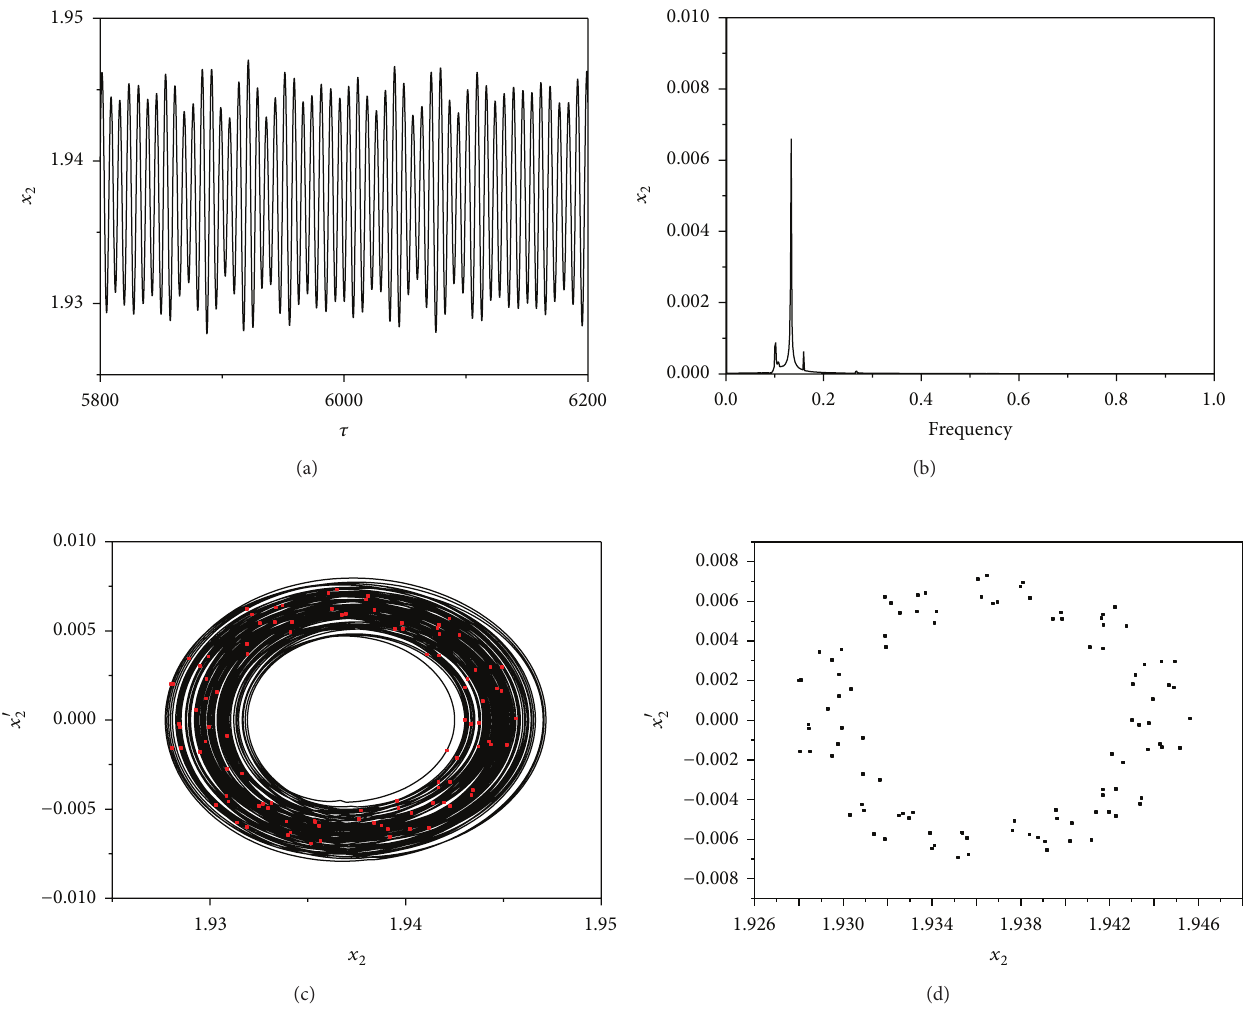
Figure 23: See 𝜔 = 1.15 . (a) Displacement response. (b) Frequency spectrum. (c) Phase-portrait plots. (d) Poincar´e